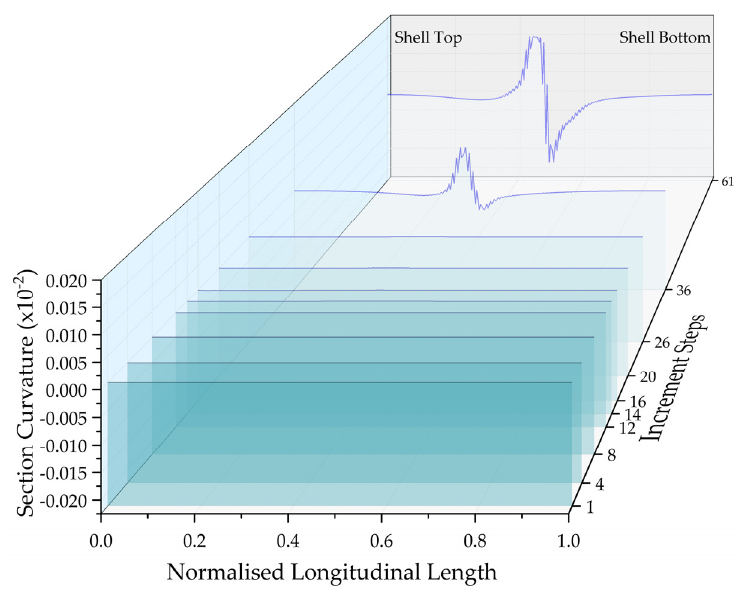
Figure 21. Shell (20 m at 24 mm) section curvature along the normalised longitudinal length at typical increment steps, under the pure bending moment.